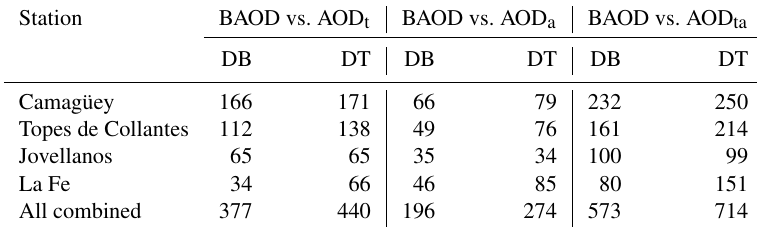
Table 7. Number of coincident cases of AOD t , AOD a , AOD ta with BAOD both for the DB and DT algorithms.